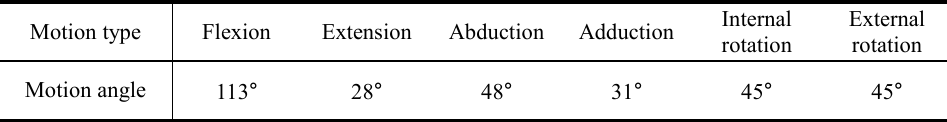
Fig. 3 Anatomical position of hip implant (45° inclination, 15° anteversion, 6° adduction, and 10° antetorsion) and six motion directions (flexion, extension, abduction, adduction, internal rotation, and external rotation) Table 3. Average ROM of normal adult male*